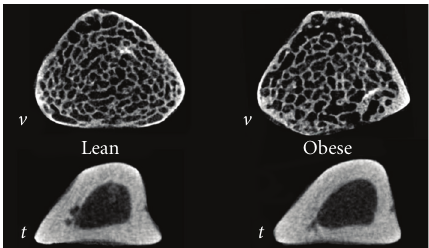
Table 1: Tibial geometrical properties.